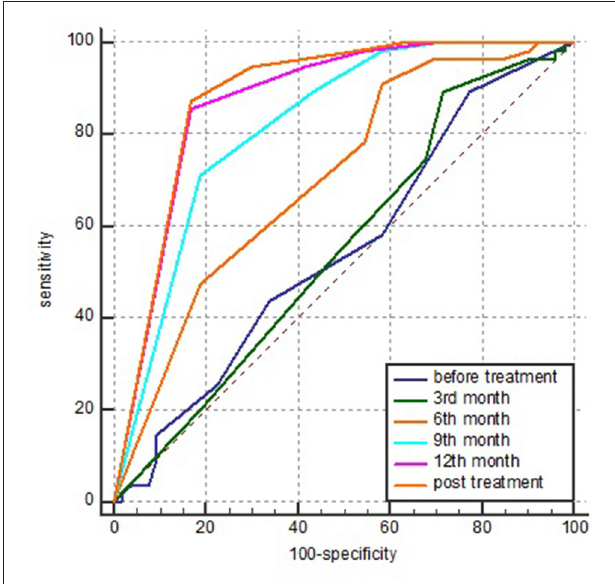
FIGURE 3 | AUC of the sign clusters of cavities detected in various stages of treatment by ROC analysis. AUC, area under the ROC curve and ROC, receiver operating